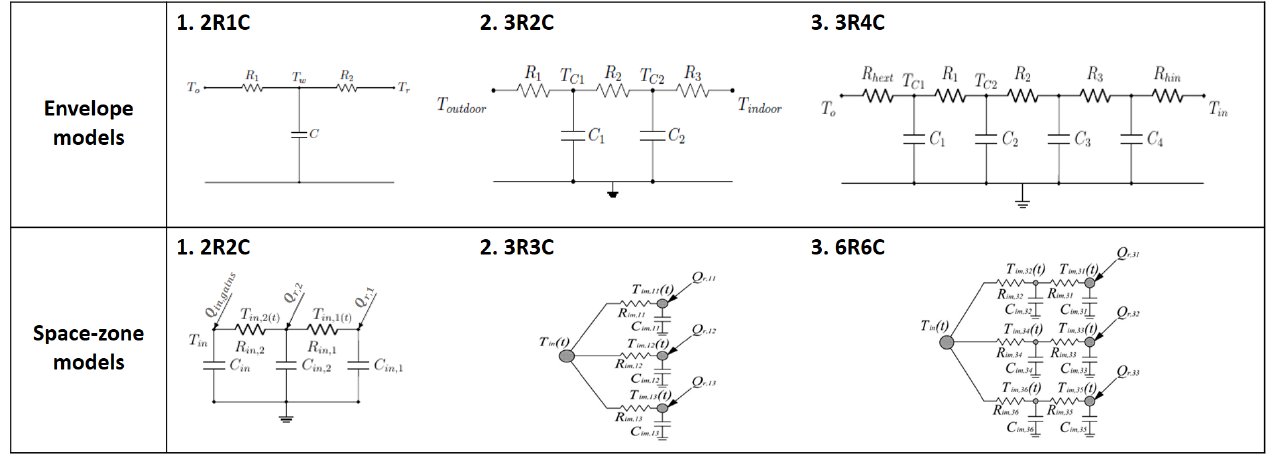
Figure 6. Major configurations of envelope and space-zone models. Reproduced from Boodi et al. [27], Fraisse et al. [67], Wang & Xu [68], and Ji et al.